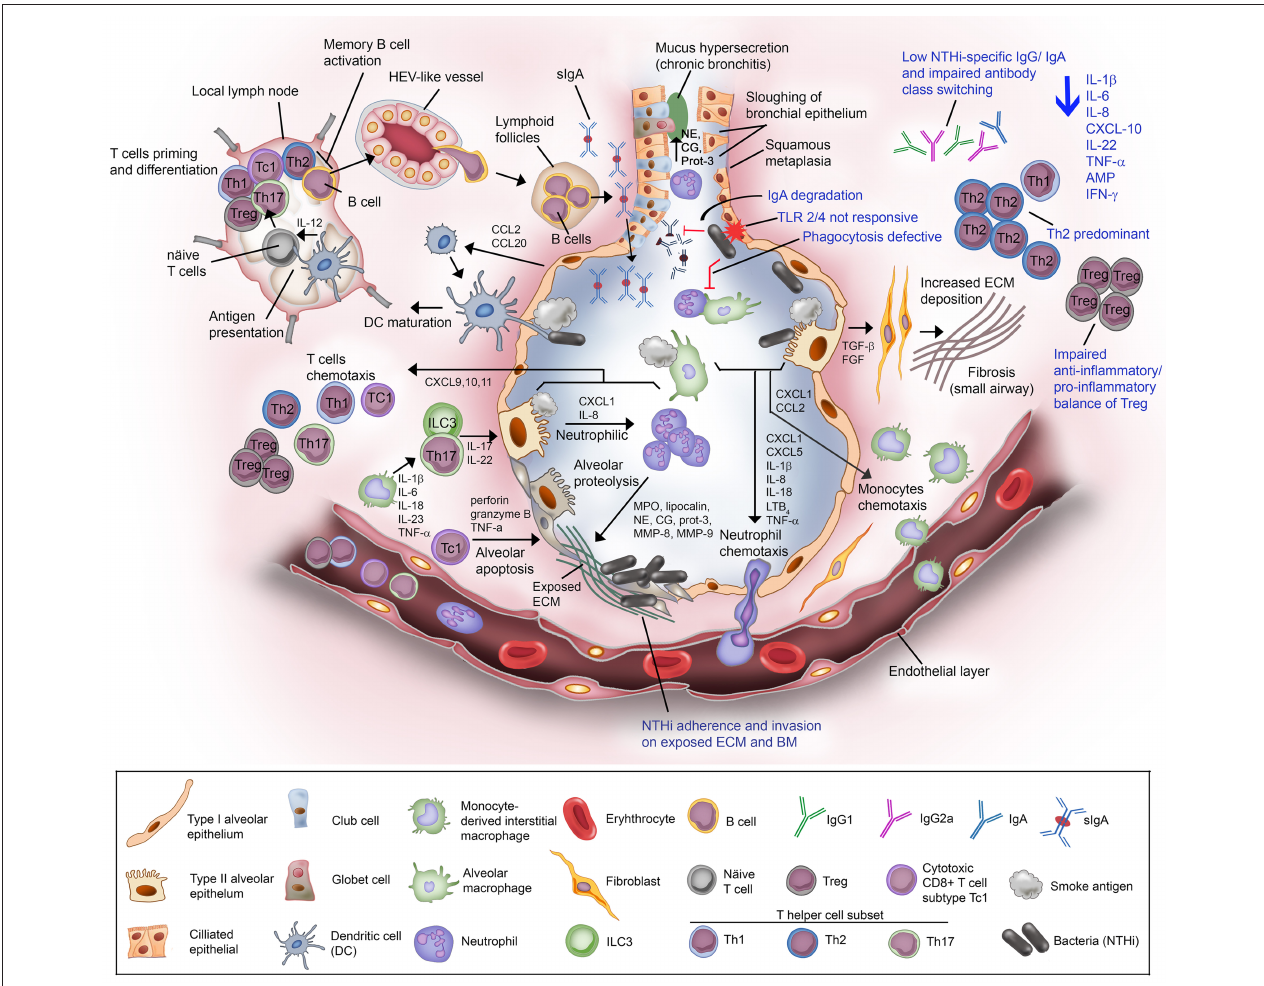
FIGURE 2 | Non-typeable H. influenzae -dependent immune responses in the lower airway of COPD patients result in inflammation. Airway epithelium exposed to cigarette or tobacco smoke display an increased permeability with compromised tight junctions, and airway remodeling (goblet cell hyperplasia and small airway squamous metaplasia). Cigarette smoke causes the activation of airway epithelium and alveolar macrophages. The activated airway structural and resident immune cells release an array of chemotactic factors responsible for recruitment of inflammatory and immune cells to the lung. Activated epithelium produces TGF- β and FGF that triggers the production of ECM molecules by fibroblasts. Increased deposition of ECM causes progression of fibrosis and air flow limitation. The chemokines CXCL1 and IL-8, and LTB 4 attract the circulating neutrophils through the receptors CXCR2 and BLT 1 , respectively. Meanwhile, CXCL1 and CCL2 targeting the receptors CXCR2 and CCR2 on blood monocytes are also released. Recruited blood monocytes differentiate into macrophages in the airway tissue. Activated alveolar macrophage and epithelium cell also release inflammasome (1L-1 β and IL-18) for neutrophils survival and activation of helper T cells Th17. The chemokine IL-23 are released by macrophages to attract T helper cell subset Th17, and ILC3. Both Th17 and ILC3 will release IL-17 and IL-22 that will act on the alveolar epithelium to release CXCL1 and IL-8 for enhanced recruitment of neutrophils, resulting in neutrophilic inflammation. Activated neutrophils are thereafter degranulated and release myeloperoxidase (MPO), lipocalin, neutrophil elastase (NE), cathepsin-G (CG), proteinase-3 (Prot-3), and matrix metalloprotease (MMP) 8 and 9. The granulated products are proteolytic and elastilolytic to aveolar, causing alveolar destruction and emphysema. In addition, NE, CG, and Prot-3 are also targeting goblet cells and submucosal glands to induce hypersecretion of mucus. Dendritic cells carrying the receptors CCR2 and CCR6 are recruited to airway tissue via chemottractants CCL2 and CCL20. The dendritic cells uptake the antigen (smoke residues), and present the antigens to the naïve T cells at lymph nodes. Uncommitted T lymphocytes are thereafter primed to the presented antigen and activated by IL-12 derived from dendritic cells (professional antigen presenting cells; APC). Mature/activated T cells expressing receptor CXCR3 are chemotactic toward CXCL9, CXCL10, and CXCL11 and are recruited to the lung tissue. Cytotoxic CD8 + T cell subtype Tc1 releases perforin and granzyme B resulting in epithelial apoptosis contributing to emphysema progression. For the humoral immune response, B cells are activated by Th2, enter the circulation via high-endothelial venule (HEV)-like vessel and transported to lung tissue, and organized into lymphoid follicles at peripheral airway. B cell-derived plasma cells from lymphoid follicles release IgA, and secreted into airway lumen as secretory IgA (sIgA) via the polymeric immunoglobulin receptor. Mucosal antibodies play an important role to eradicate pathogens and noxious antigens via immune exclusion. However, the airway defense by sIgA is diminished by NTHi IgA protease that degrade the antibodies. TLR2 and TLR4 of the airway phagocytes and epithelium following exposure to cigarette smoke are not responding to P6 and LOS of NTHi. This results in defective phagocytosis and delayed bacterial clearance from the airway. The suppressed TLR4 induction in T cells has also lead to Th2 predominant immune response, with low production of IFN- γ and reduced T cell-mediated immune killing of NTHi. Moreover, NTHi downregulates Foxp3 of Tregs and thus impairs the anti-inflammatory/pro-inflammatory balance of Tregs. The extensive immunosuppressive activity by Tregs diminishes the response of effector T